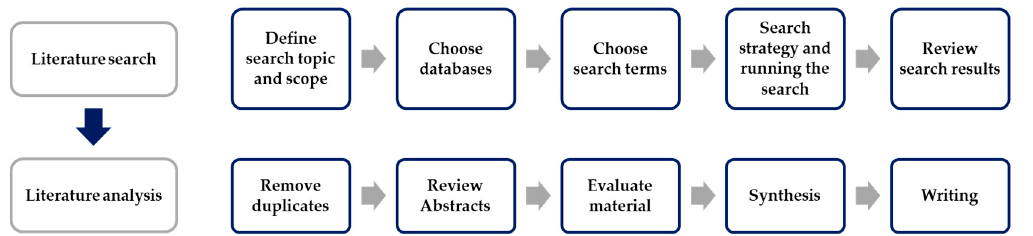
Figure 3. Steps followed in the systematic literature review (SLR).